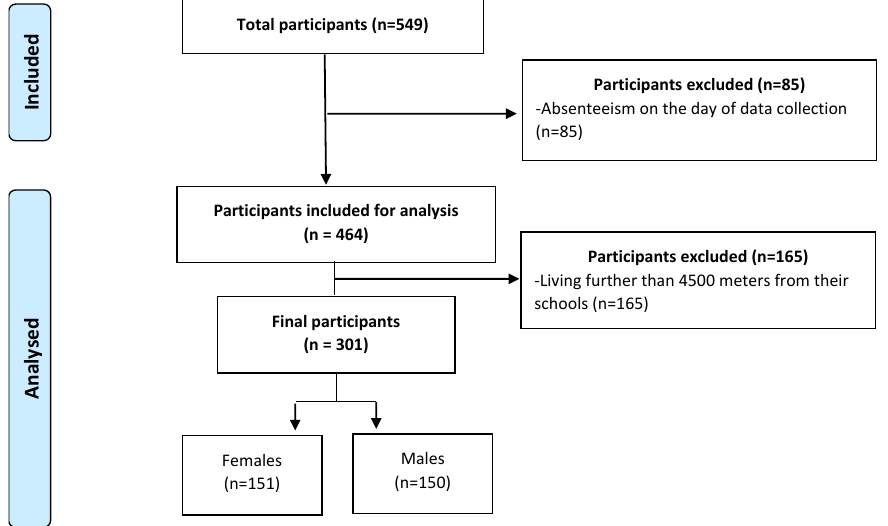
Figure 1. Study selection flow Figure 1 . Study selection flow chart.